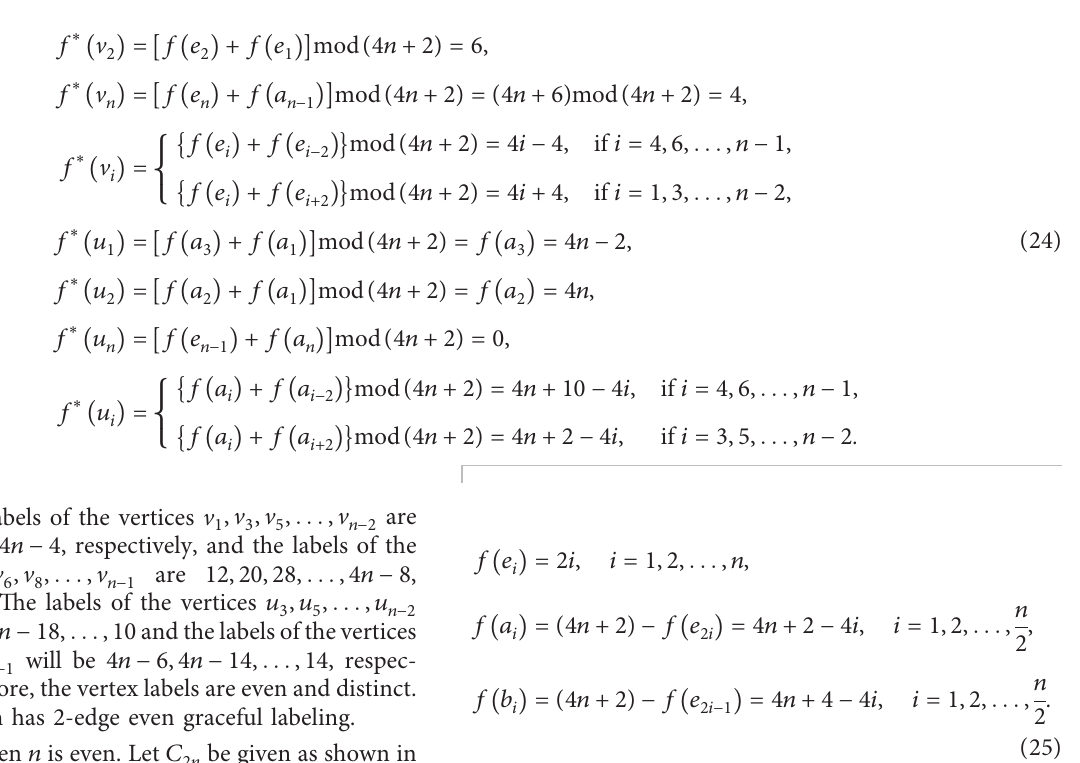
with ordinary labeling when n is 2 n